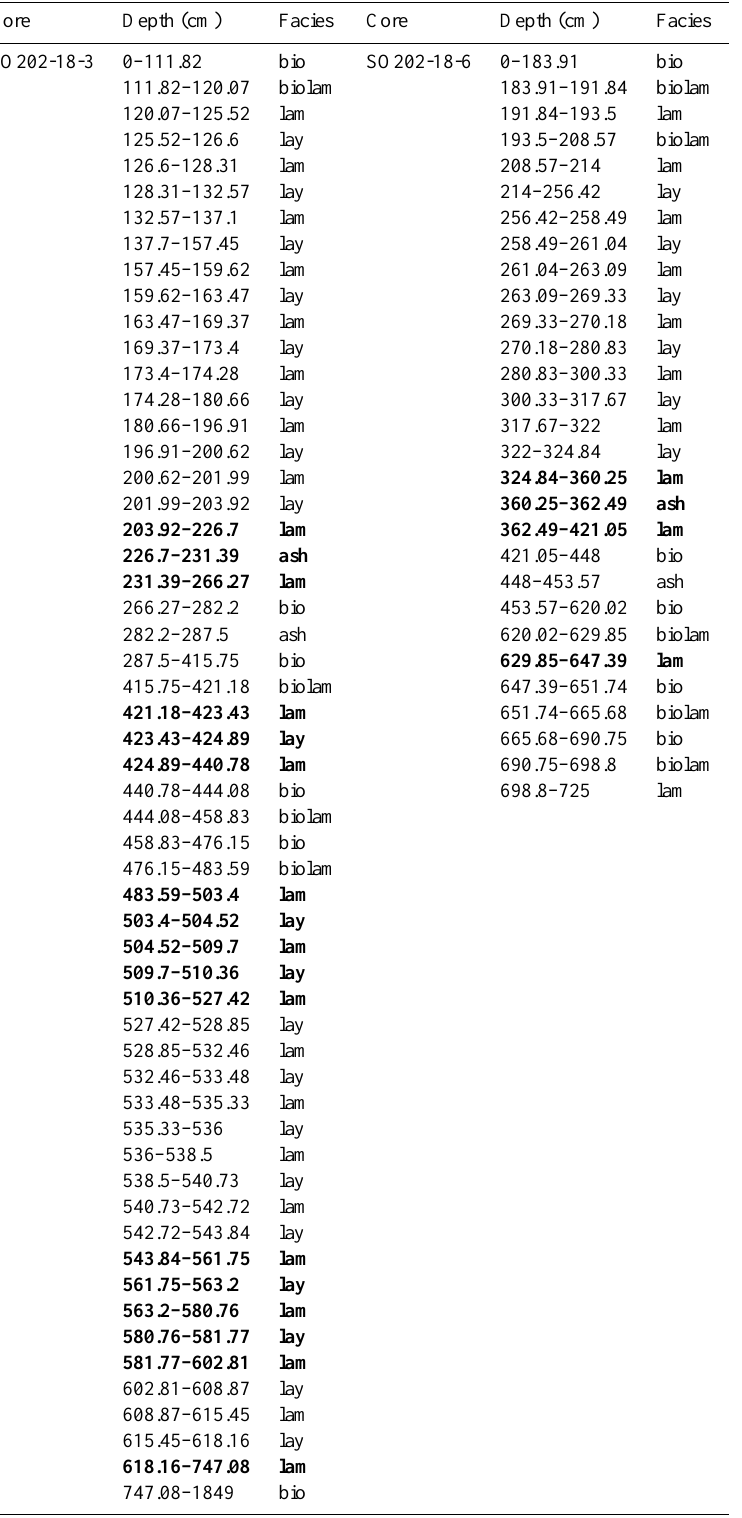
Table 3. Core depths of the different facies types occurring in cores SO202-18-3 and SO202-18-6: lam: Laminated Facies; lay: Layered Facies; biolam: Bioturbated Lamination Facies; bio: Bioturbated Facies; ash: ash layer. Depth intervals of prominent laminated units (TI- BLU1–5) are marked